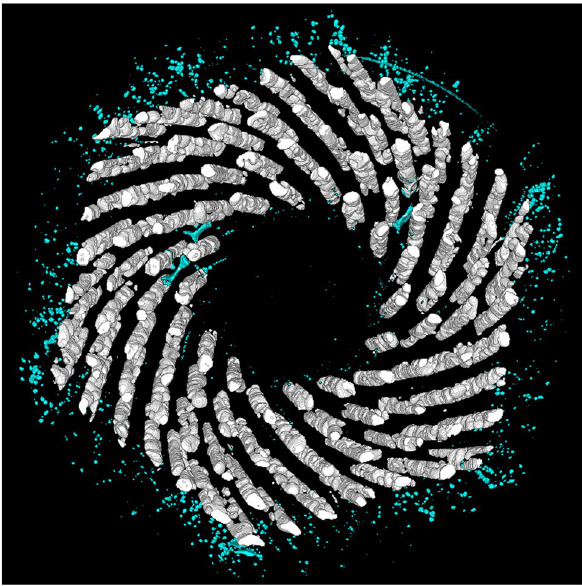
Figure 3. The 3D voids reconstruction of the sample S20. The voids in the sub-elements are white while the copper voids are light blue. The image was generated by using the Fiji (Fiji is Just ImageJ) distribution of ImageJ 40 . [ImageJ-1.53c https:// imagej. net/